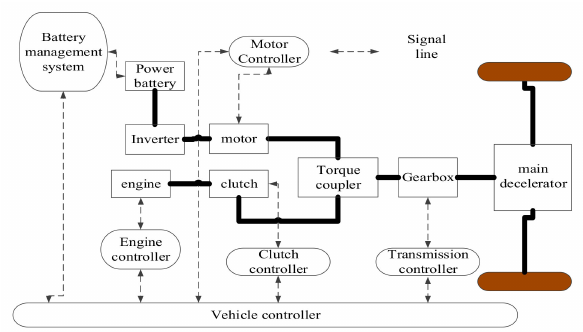
Figure 1. Schematic diagram of the hybrid power system